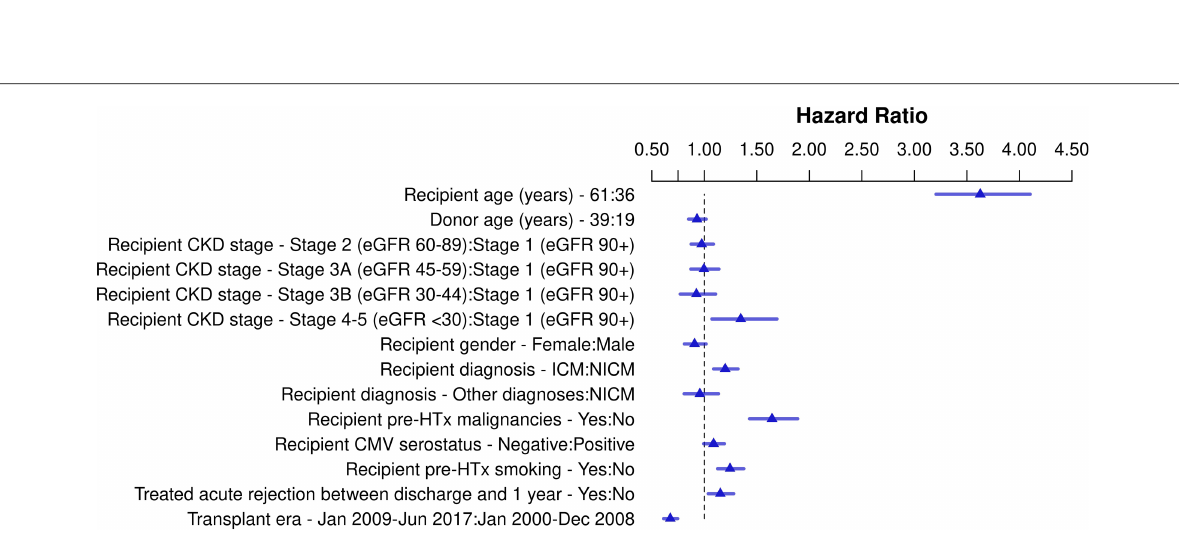
FIGURE 3 Schematic overview for risk factors for solid-organ malignancy post-heart transplant. Hazard ratios for continuous variables are shown for the third quartile vs. the fi rst quartile. CKD, chronic kidney disease; CMV, cytomegalovirus; eGFR, estimated glomerular fi ltration rate; HTx, heart transplantation ICM, ischemic cardiomyopathy, NICM, non-ischemic